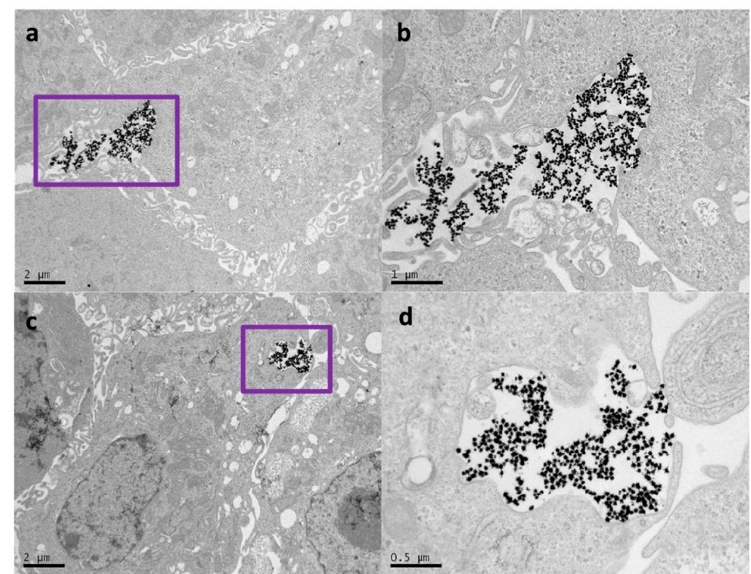
Figure 6. ( a ) TEM micrograph of a single cell where a big membrane invagination can be observed and ( b ) image at higher magnification. Another example of the exocytosis and re-endocytosis of Au NSs is shown in ( c ) and at higher magnification in ( d ).